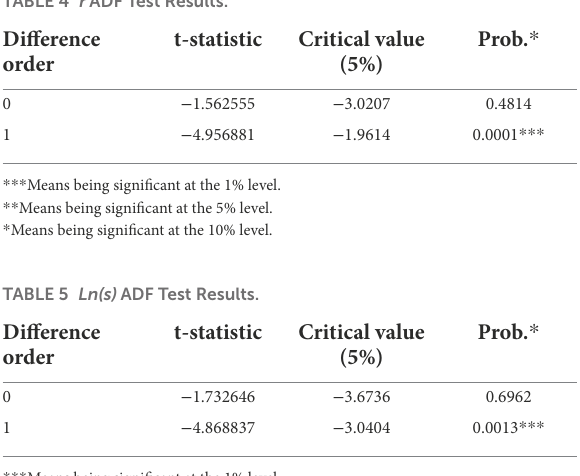
TABLE 4 r ADF Test Results.